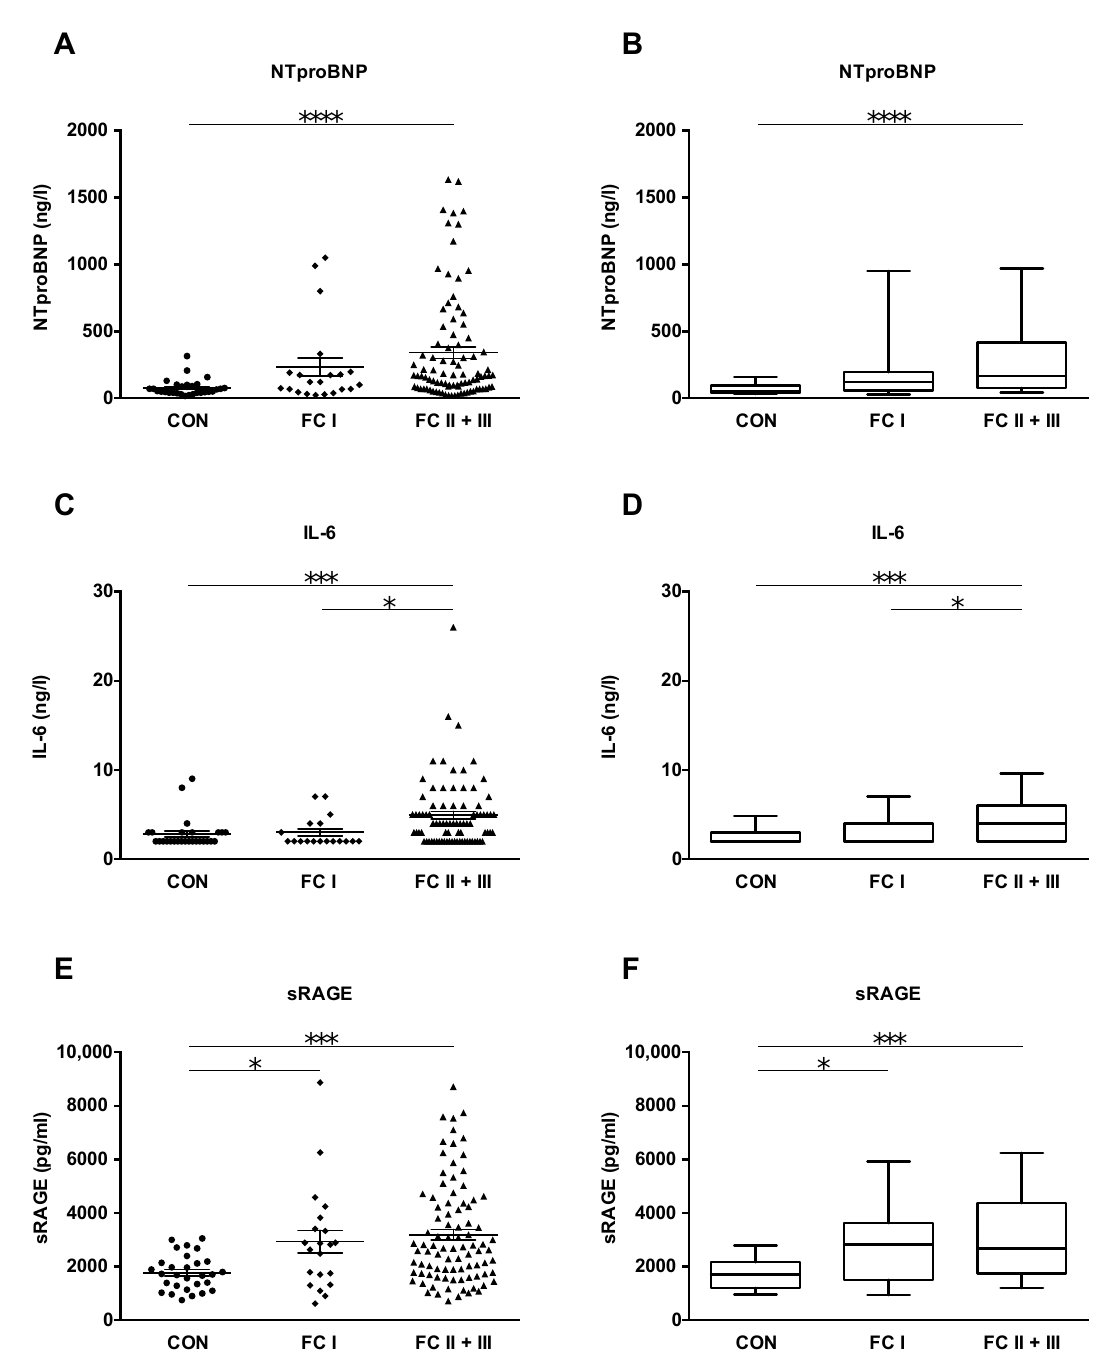
Figure 2. NTproBNP, IL-6 and sRAGE plasma concentrations in patients with idiopathic pulmonary arterial hypertension (IPAH) and connective tissue disease-associated pulmonary arterial hypertension (CTD-PAH) increase with pulmonary hypertension severity. The World Health Organization (WHO) functional class (FC) system is used as a surrogate for disease severity. Functional classes I-III include both IPAH and CTD-PAH patients. ( A , B ) Plasma levels of NTproBNP in controls (n = 29), patients with FC I (n = 21) and FC II and III (n = 90). ( C , D ) Plasma levels of IL-6 in controls (n = 27), patients with FC I (n = 18) and FC II and III (n = 83). ( E , F ) Plasma levels of sRAGE in controls (n = 29), patients with FC I (n = 21) and FC II and III (n = 90). The scatter plots on the left show the mean ± SEM, the box and whisker plots on the right show the median with interquartile range ± 10-90 percentile. Statistical test: Kruskal–Wallis test, corrected for multiple testing by Dunn’s test. * p < 0.05, *** p < 0.001. **** p < 0.0001. Abbreviations: IL-6, Interleukin-6; NTproBNP, N-terminal pro-brain natriuretic peptide; sRAGE, soluble receptor for advanced glycation end